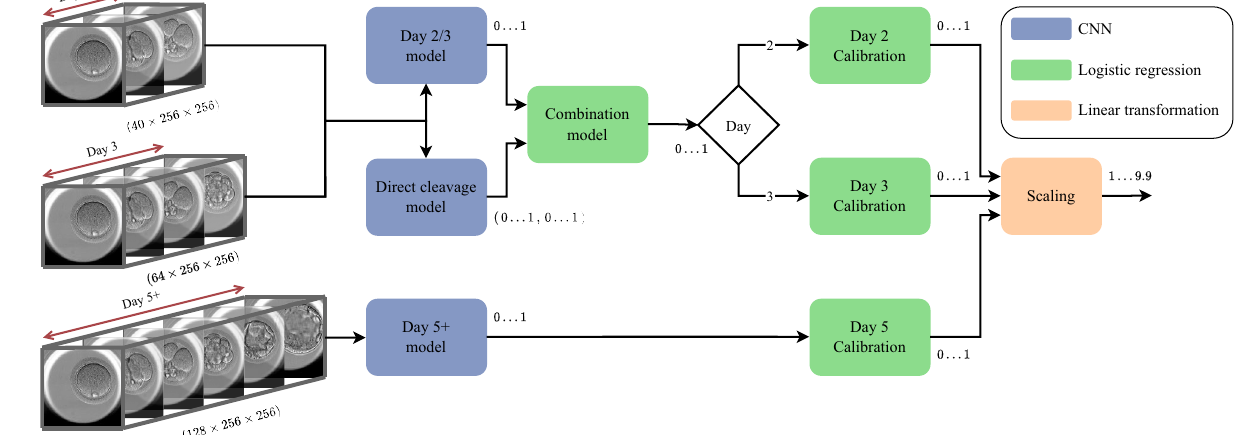
Figure 1. iDAScore v2.0. Two separate tracks handle day 2/3 and day 5+ embryos. The first track consists of two 3D convolutional neural networks (CNN) that predict implantation potential and direct cleavages, followed by separate calibration models for day 2 and 3. The second track consists of a 3D CNN that predicts implantation potential followed by a day 5+ calibration model. Finally, scores from both tracks are scaled linearly to the range